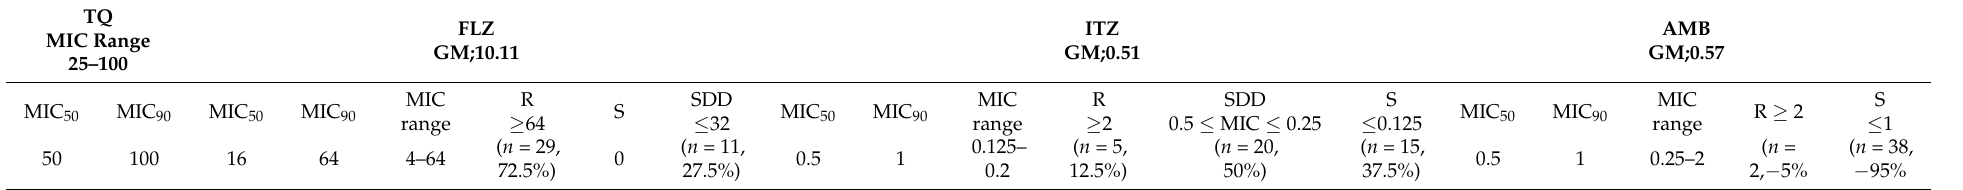
Table 3. Antifungal susceptibility pattern of the C. glabrata isolates against antifungal